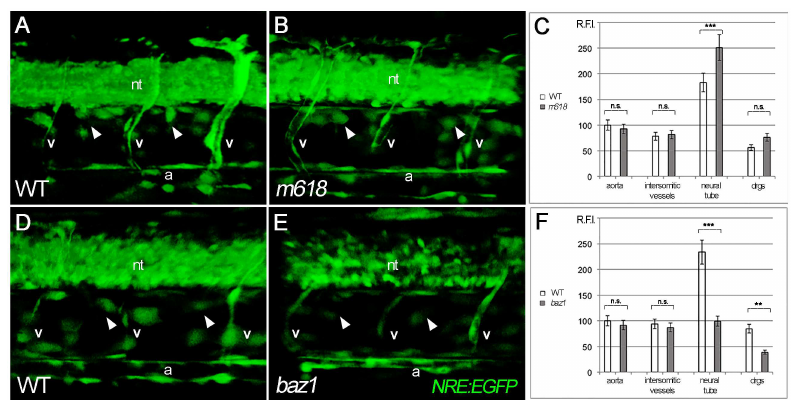
Fig 7. Quantification of Notch reporter differences in m618 and baz1 mutants at 48 hpf. A-F) confocal acquisitions of WT control (A,D) and mutant (B, m618 ; E, baz1 )trunk regions, followedby Notch reporter (NRE:EGFP) fluorescence analysis(C,F). A slight increaseof reporter signal is detected in the neuraltube (nt) and dorsal root ganglia(drg, arrowhead) of m618 mutants (B) comparedto controls (A), whilea decrease of signalis detected in the same regions of baz1 mutants (compareE with D). Relativefluorescence intensity (RFI) in aorta (a) and intersomiticvessels (v) appearsunmodifiedin all conditions. n = 6 measurements per condition. n.s. = not significant; ** = p < 0.01; *** = p <